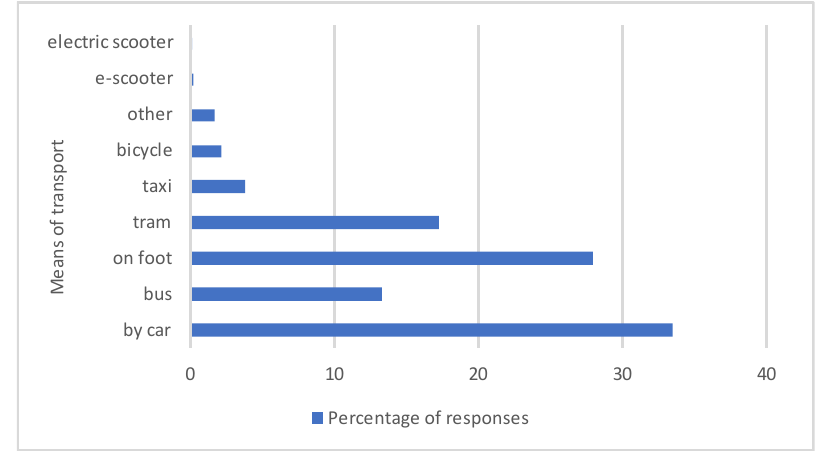
Figure 2. The statistics on the respondents ’ chosen means of transport in all directions. Many respondents mentioned hiking trips. This may be an effect of the COVID- activities. Walking trips were most common among students, who accounted for more than half of the respondents. in detail in Figure 3.